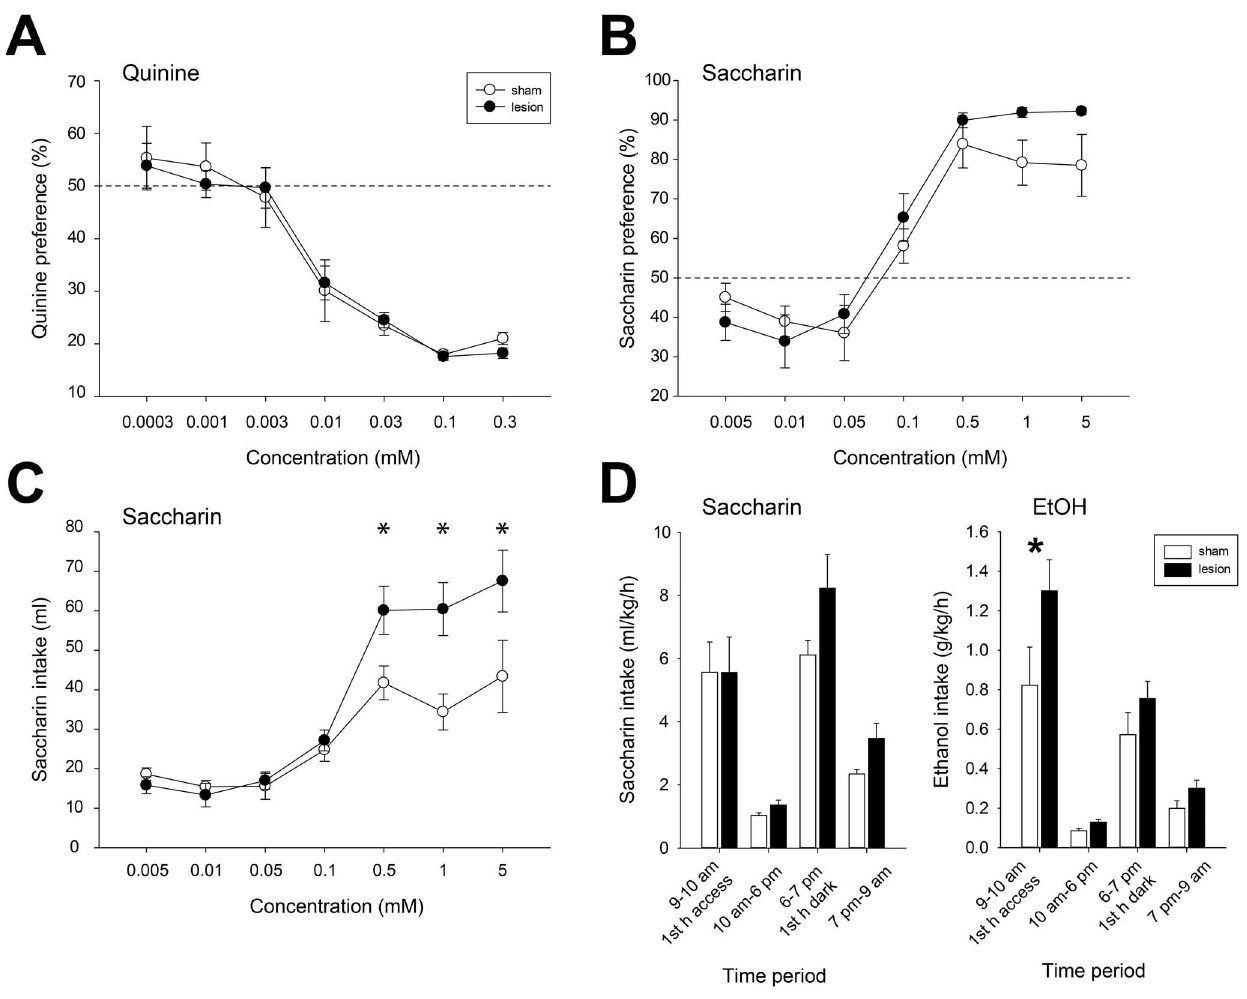
Figure 3. Taste preference. (A) Aversion to quinine did not differ between sham and lesioned rats. (B) Preference for saccharin did not significantly differ between sham and lesioned rats, despite quantitatively increased preference in lesioned rats at saccharin concentrations of 0.5 mM and above. (C) Saccharin intake was significantly higher in lesioned rats at concentrations of 0.5 mM saccharin and above. (D) Timeline of saccharin (left panel) and ethanol (right) intake over 24 hour sessions. The pattern of saccharin intake over 24 hours did not differ between sham and lesioned animals. Rates of intake were similar in the first hour of saccharin access and highest for both groups in the first hour of the dark cycle. By contrast, rates of 20% ethanol intake were higher in lesioned rats specifically during the first hour of access. session were 11 6 3 lever presses for lesioned rats and 14 6 4 for sham rats.